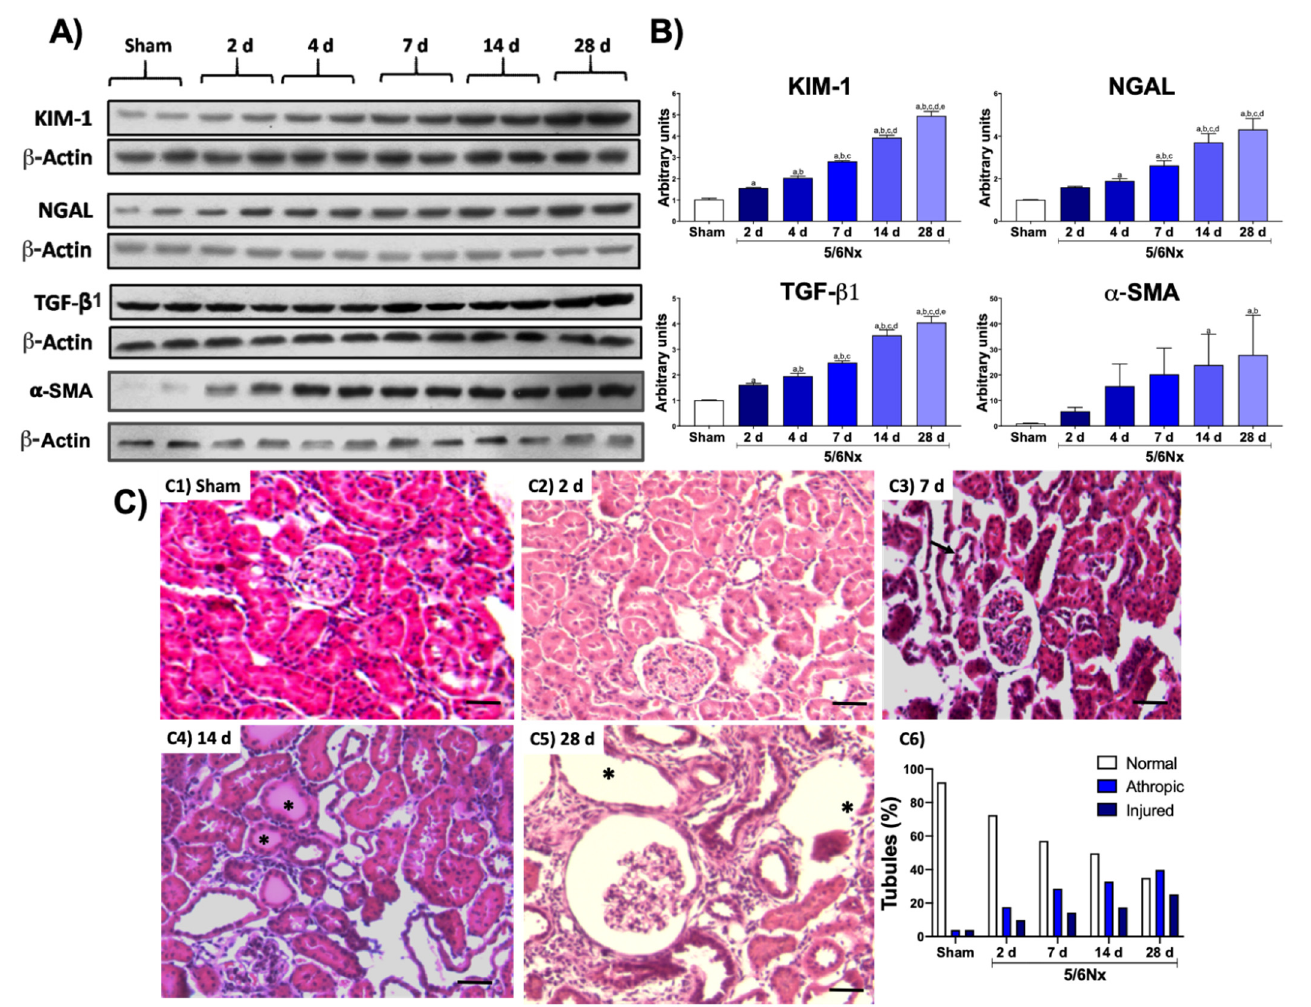
Figure 1. Temporal progression of kidney damage. ( A ) Representative Western blots of renal damage markers and fibrotic markers. ( B ) Quantifications of renal damage markers kidney injury molecule-1 (KIM-1) and neutrophil gelatinase- associated lipocalin (NGAL), as well as the profibrotic molecule transforming growth factor beta (TGF- β 1) and alpha smooth muscle actin ( α -SMA). β -Actin was used as loading control. Data are the mean ± SEM, n = 4. Tukey test. a = p ≤ 0.05 vs. sham, b = p ≤ 0.05 vs. 2 days, c = p ≤ 0.05 vs. 4 days, d = p ≤ 0.05 vs. 7 days, e = p ≤ 0.05 vs. 14 days, sham = simulated operation/control group. ( C ) Representative micrographs of kidney: ( C1 ) Normal kidney histology from sham animal. ( C2 ) After 2 days of 5/6 nephrectomy (5/6Nx), there were occasional cortical proximal tubules with flattened epithelium that correspond to tubular atrophy (arrows). ( C3 ) After 1 week of nephrectomy, more tubules showed extensive epithelium damage (arrows). ( C4 ) After 2 weeks of kidney resection, even more tubules show epithelial damage with hyaline casts in their lumen (asterisks). ( C5 ) After 5/6Nx, there were numerous atrophic and dilated tubules (asterisks), as well as a glomerulus with mesangial hypercellularity surrounded by mild inflammatory infiltrate and fibrosis. ( C6 ) The morphometric determination of tubular damage confirmed the progressive tubular damage when compared with the sham simulated/control group (S). (H/E staining, all micrographs 200 × magnification, scale magnification bar = 50 µ